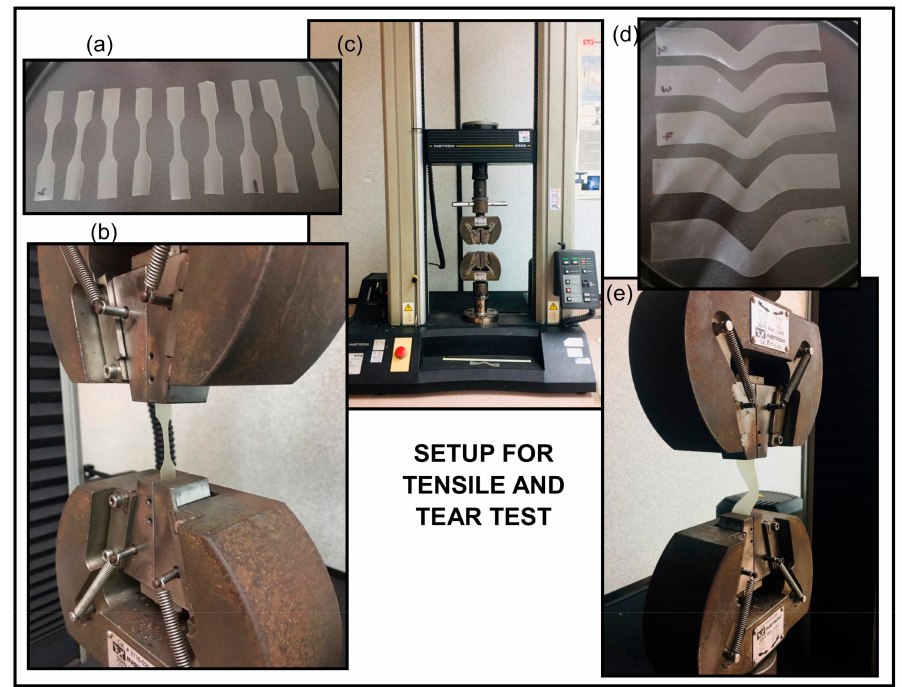
Figure 5. Setup for tensile and tear tests: ( a ) dumbbell-shaped samples for tensile test, ( b ) sample loading for tensile test, ( c ) Instron machine model 5569 to perform tensile and tear tests, ( d ) samples for tear test, ( e ) sample loading for tear